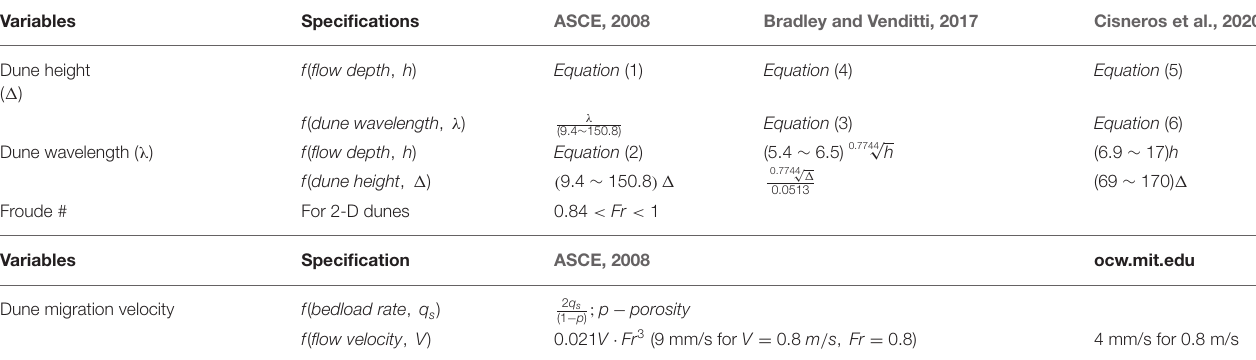
TABLE 1 | Selected predictive formulas for estimation of bedform geometry and